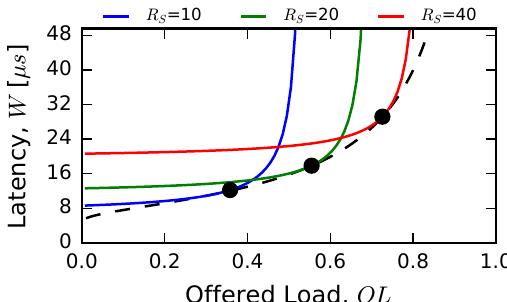
Figure 17. Latency prediction plot vs. offered load for the AES application. C = 14, N = 8 C , and S = 120. A 3 dB point is drawn for each curve above the minimum latency to approximate the knee of the curve. The dashed black curve is a lower bound of the optimal latency for R S optimized at each offered load.